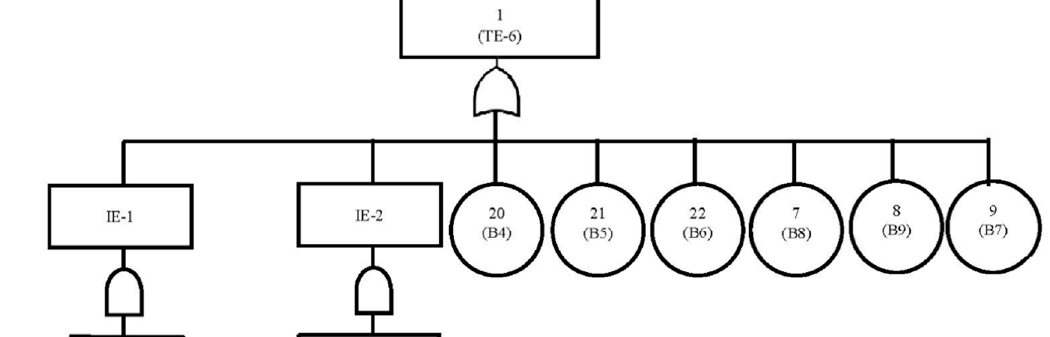
Figure 6. Simplification of FT-5.